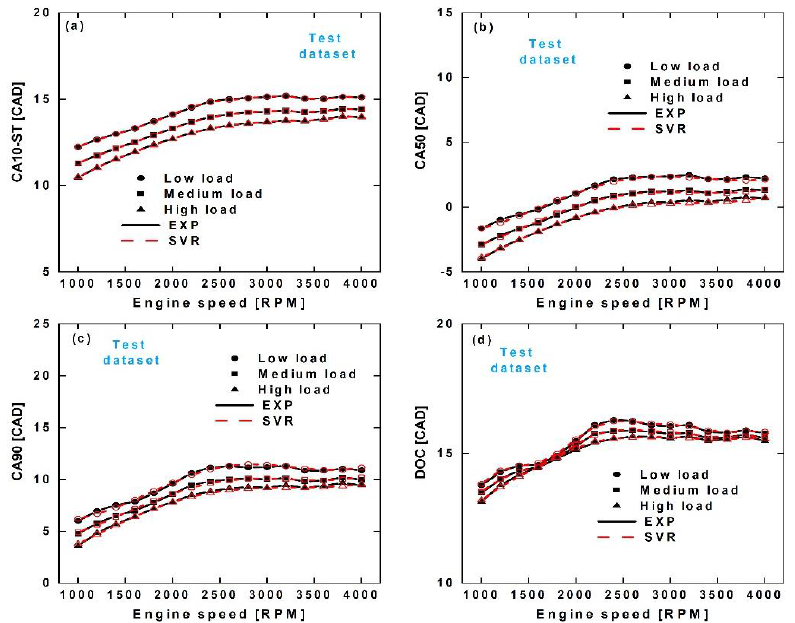
Figure 12. Effect of engine speed on the combustion phasing, at constant spark timing ( − 20 CAD ATDC). ( a ) CA10 − ST; ( b ) CA50; ( c ) CA90; and ( d ) DOC.